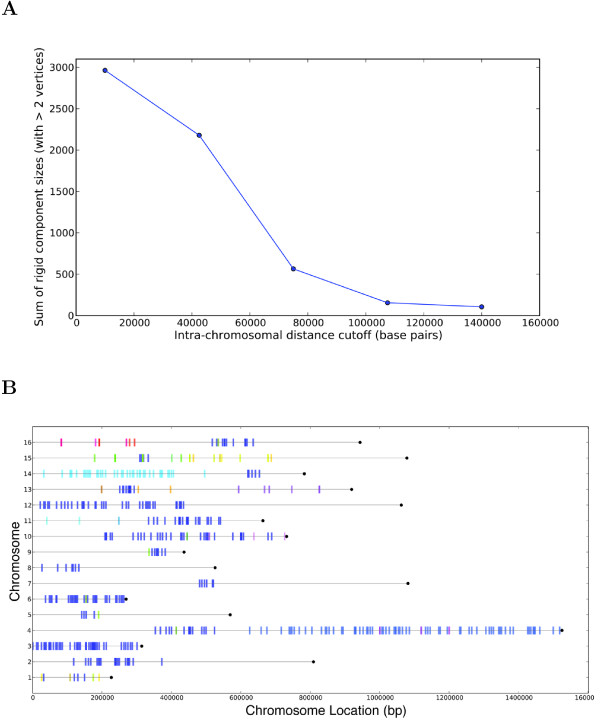
Rigid components after removing short-range interactions. (A) Sum of rigid component sizes after removing all interactions below increasing intra-chromosomal distances (98.8% frequency cutoff). (B) Chromosomal locations of rigid components after removing intra-chromsomal interactions that occur within 75kbp for the Duan et al. chromosome conformation graph (98.8% frequency cutoff). Bars indicate centers of the fragments involved in a rigid component, and colors indicate the various components.